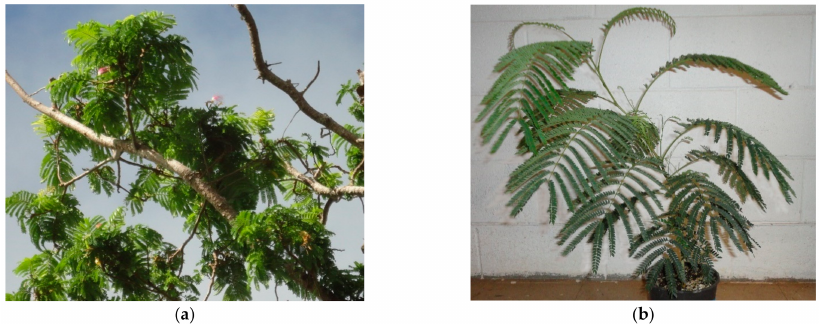
Figure 1. Vegetative organs of Serianthes nelsonii exhibit rapid growth rates. ( a ) One month after complete defoliation during a 15 May 2015 tropical cyclone, the emergent canopy of a mature tree exhibited fully expanded healthy leaves and flowers; ( b ) A five-month-old nursery plant exhibited rapid stem growth and robust leaves due to shade and under-watering in the nursery. The rapid stem growth produced weak stems that were unable to maintain orthotropic orientation, inducing lateral bud growth that reduced plant